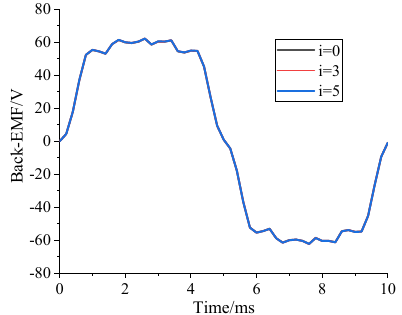
Figure 17. Voltage Waveform of back EMF.